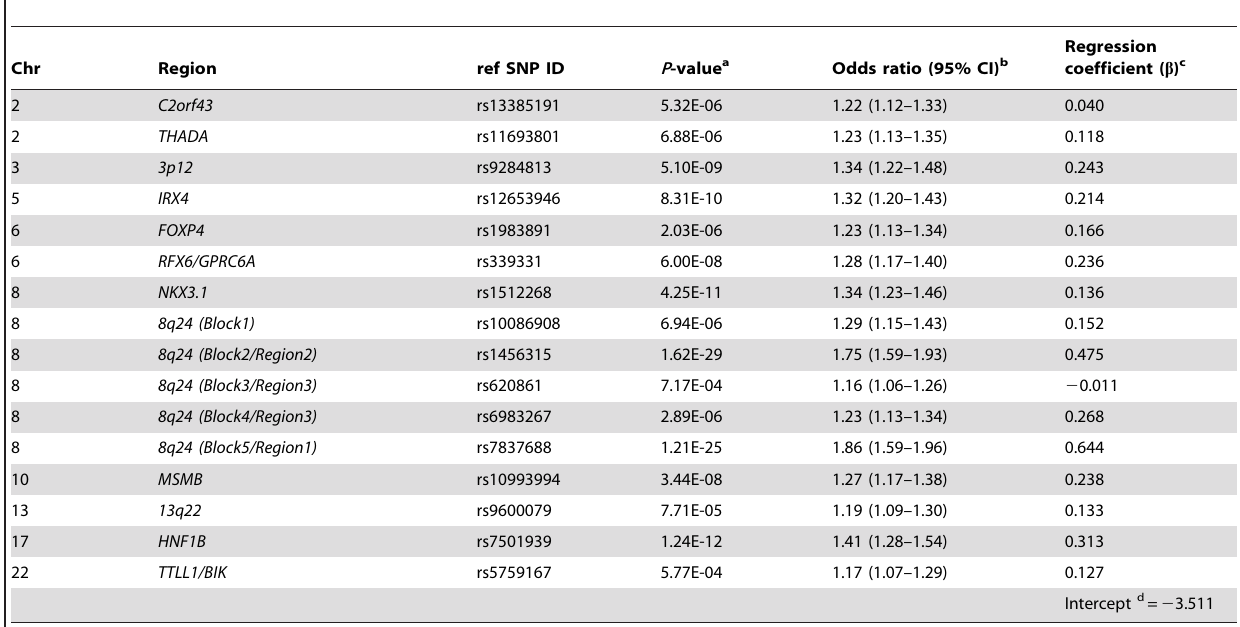
Table 1. 16 SNPs incorporated in the risk prediction model and their regression coefficients in the